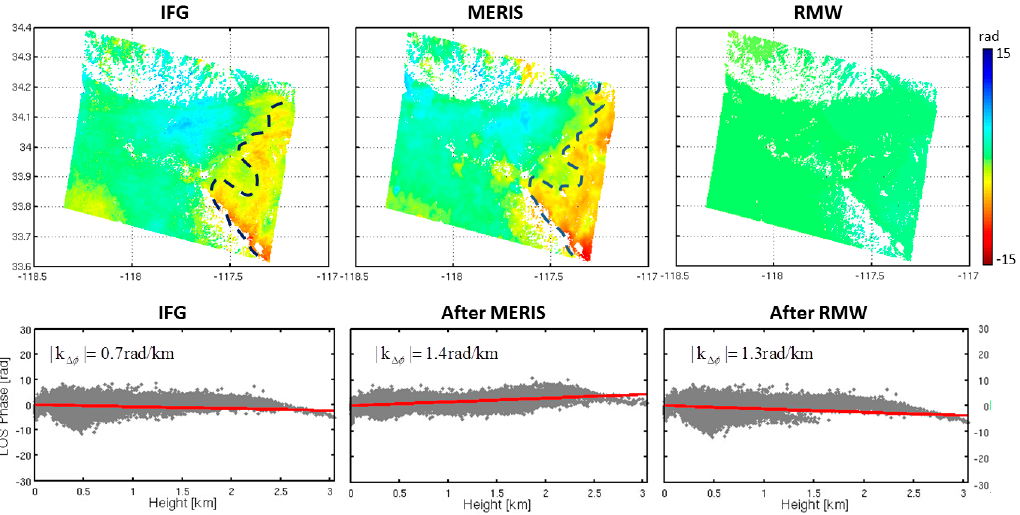
Figure 12. A comparison of the performance of the MERIS correction and the RMW method correction. A turbulent dominant interferogram was generated using two SAR acquisitions collected on 23 May 2009 and 27 June 2009. The average B K is 406 m. The original interferogram was corrected for residual orbital errors. As shown, the troposphere delay is not linearly related to topography. The standard deviation reduced by about 42% after correction with MERIS while the standard deviation increased about 8% after correction with the RMW method.